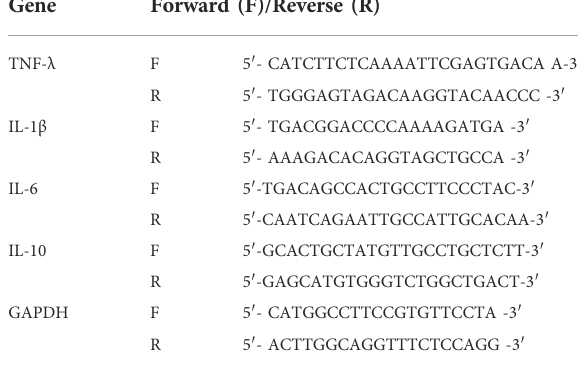
TABLE 1 Chosen primer